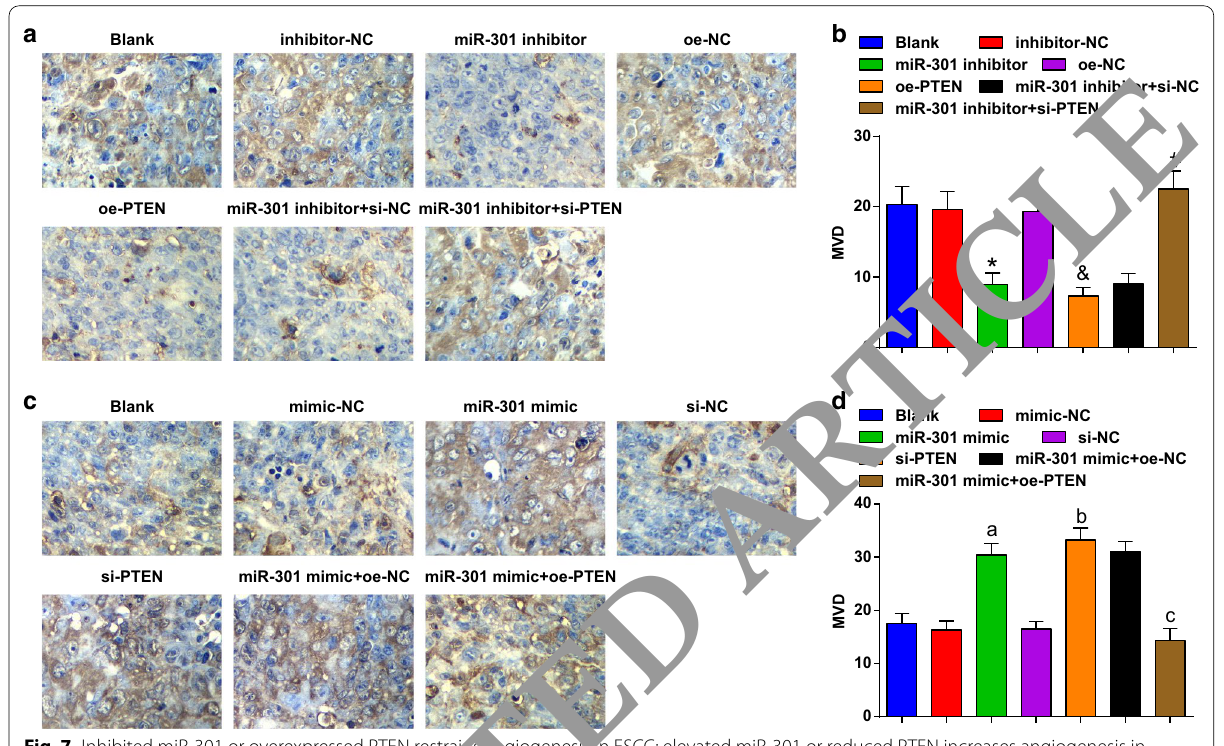
Fig. 7 Inhibited miR-301 or overexpressed PTEN restrains angiogenesis in ESCC; elevated miR-301 or reduced PTEN increases angiogenesis in ESCC. a Representative images of tumor tissues observed by immunohistochemical staining in nude mice after KYSE-30 cells were transfected; b comparisons of MVD of KYSE-30 in tumor tissues among the groups; c representative images of tumor tissues observed by immunohistochemical staining in nude mice after Eca109 cells were transfected; d comparisons of MVD of Eca109 in tumor tissues among the groups * P < 0.05 versus the inhibitor-NC group; & P < 0.05 versus the oe-NC group; # P < 0.05 versus the miR-301 inhibitors P < 0.05 versus the si-NC group; c P < 0.05 versus the miR-301 mimic and ANOVA was used for comparisons among multiple